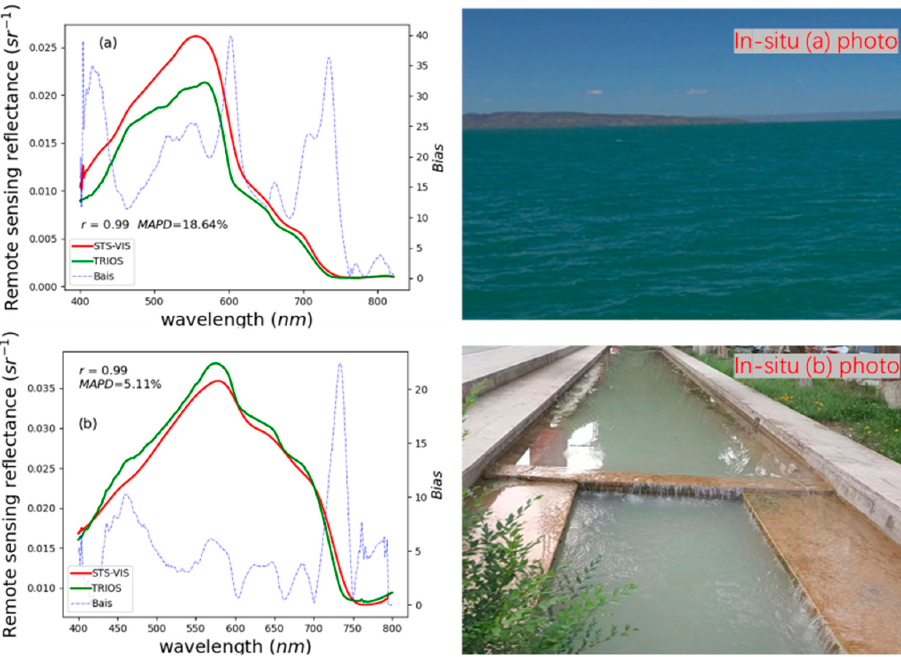
Figure 6. Micro-spectrometer measurements of clear water and turbid water R rs and bias, and in situ photos of ( a ) spectrum of Qinghai Lake, ( b ) spectrum of Golmud city River.